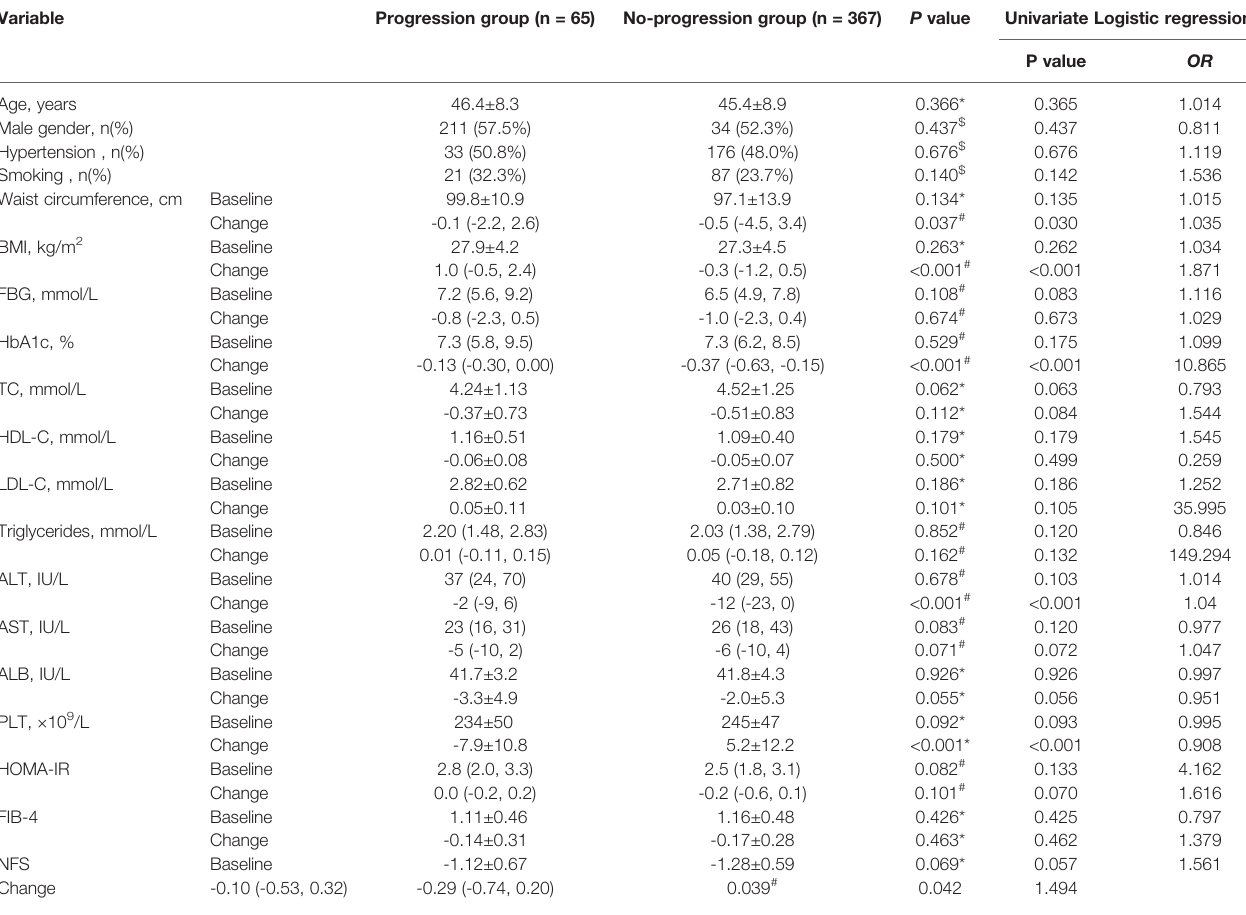
TABLE 1 | Potential variables related to fi brosis progression in T2DM patients with NAFLD who were followed up for more than 3 years.